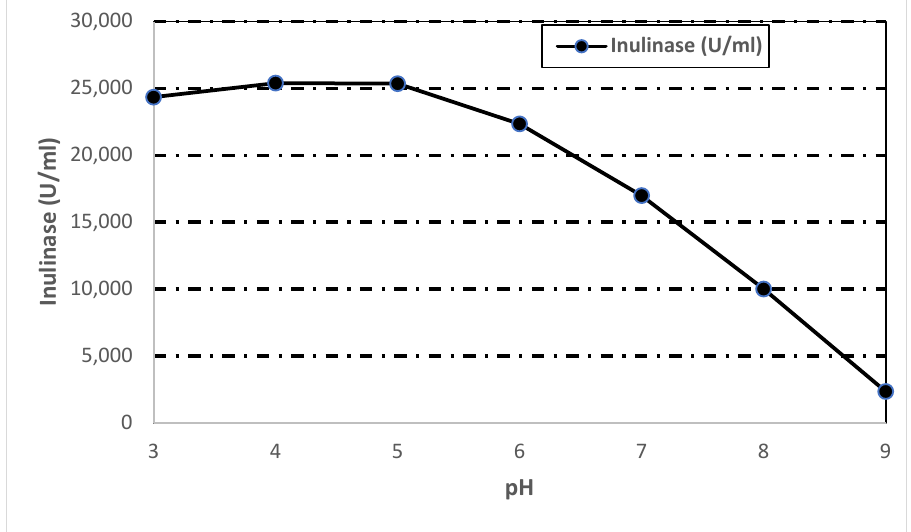
Figure 5. pH optima of the purified inulinase from Rhizopus oryzae NRRL 3563.